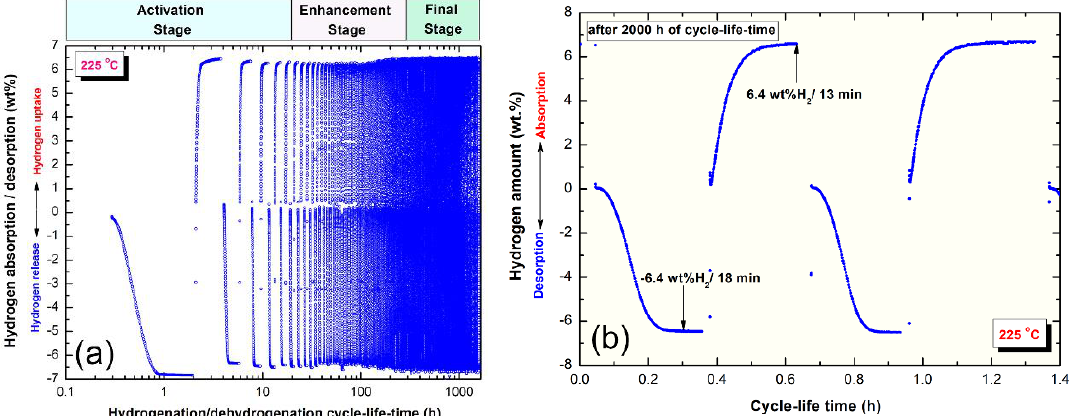
Figure 12. ( a ) Cycle-life-time of nanocomposite MgH 2 /7 wt% a-LaNi 3 powders obtained after rod-milling for 100 h. The results shown in the figure may be classified into (i) activation, (ii) enhancement and (iii) final